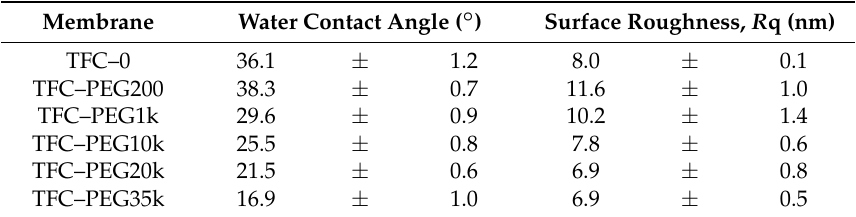
Table 4. Water contact angles and surface roughness of TFC membranes prepared using PEG of varying molecular weights.